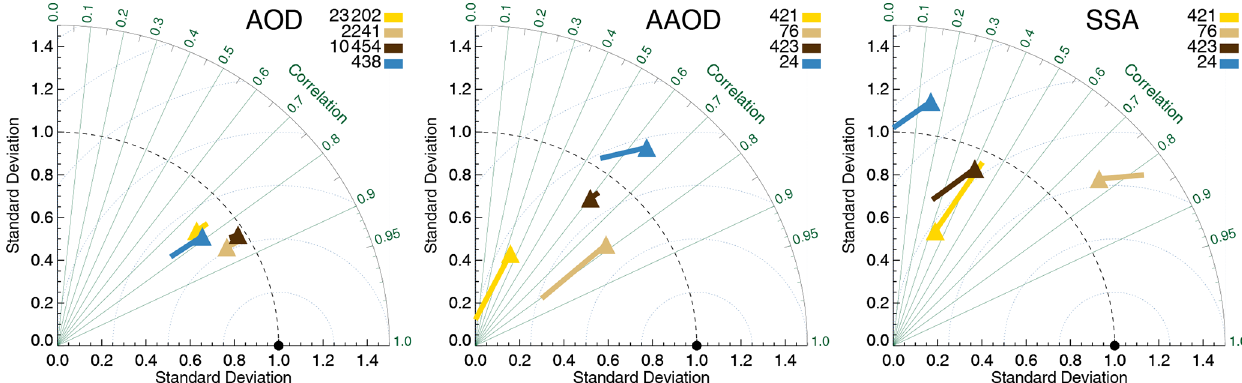
Figure 5. Taylor diagrams (for an explanation, see Sect. 3.1) for the satellite products. AOD is evaluated against AERONET DirectSun L2.0, and AAOD and SSA are evaluated against AERONET Inversion L2.0. Colours indicate the satellite product (see also Fig. 1), and numbers next to coloured blocks indicate the amount of collocated data. The lines extending from the data points indicate the bias. Products were individually collocated with AERONET within 3h.